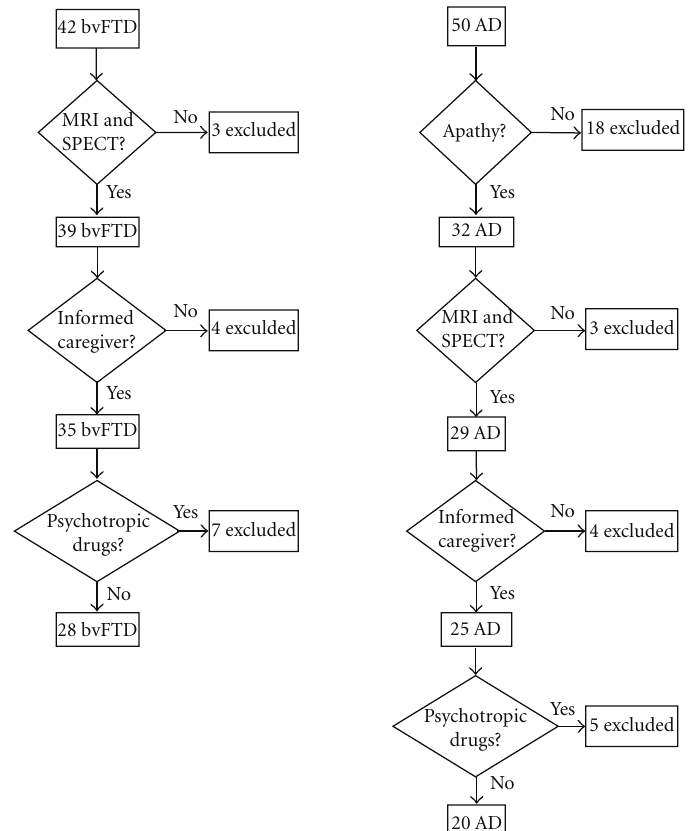
Figure 1: patients’ selection work-flow. bvFTD: behavioral variant of frontotemporal dementia; AD: Alzheimer’s